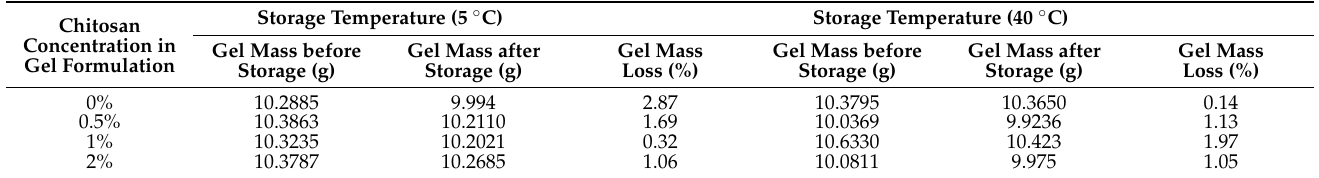
Table 1. Syneresis test result at two different temperatures of 5 ◦ C and 40 ◦ C for different gel formulation. Storage Temperature (5 ◦ C) Storage Temperature (40 ◦ C) Chitosan Concentration in Gel Mass before Gel Formulation Storage (g)